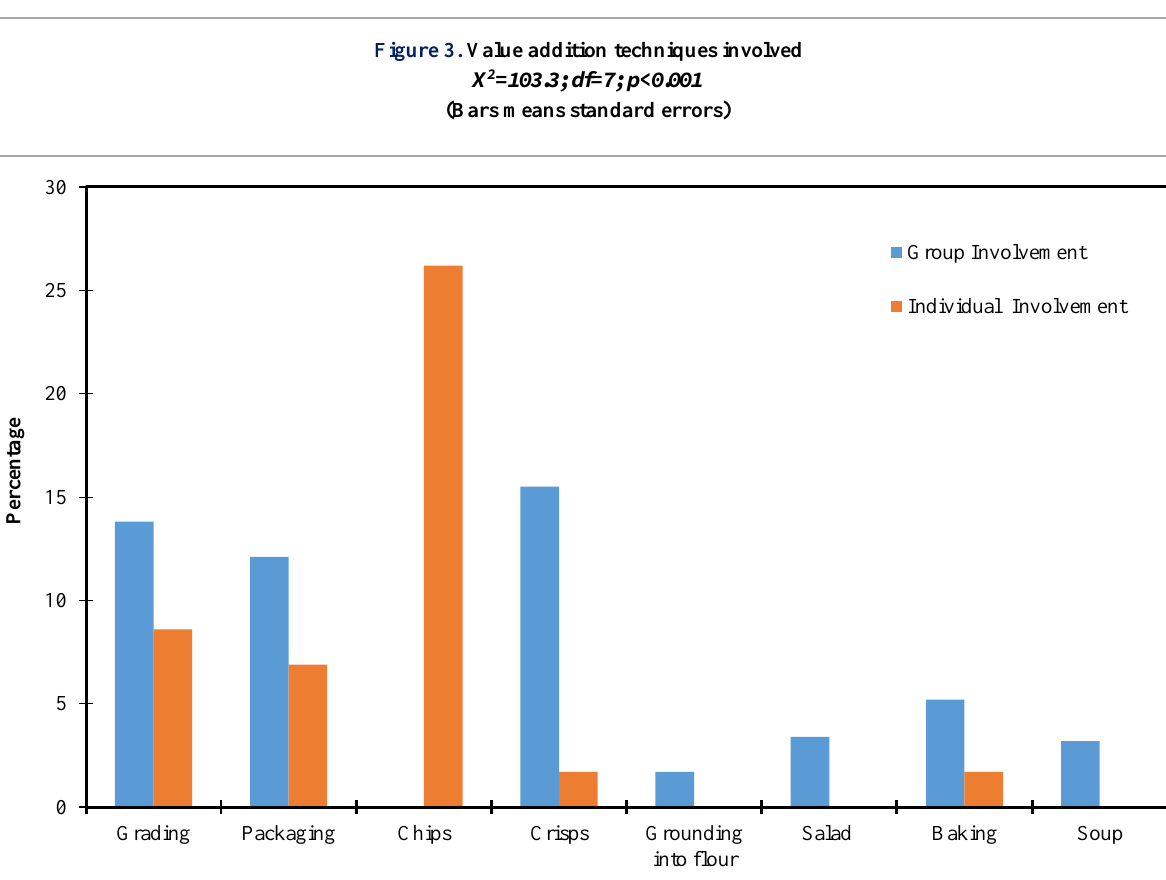
Figure 4. Value addition techniques in terms of group and individual involvement X 2 =42.657; df=7